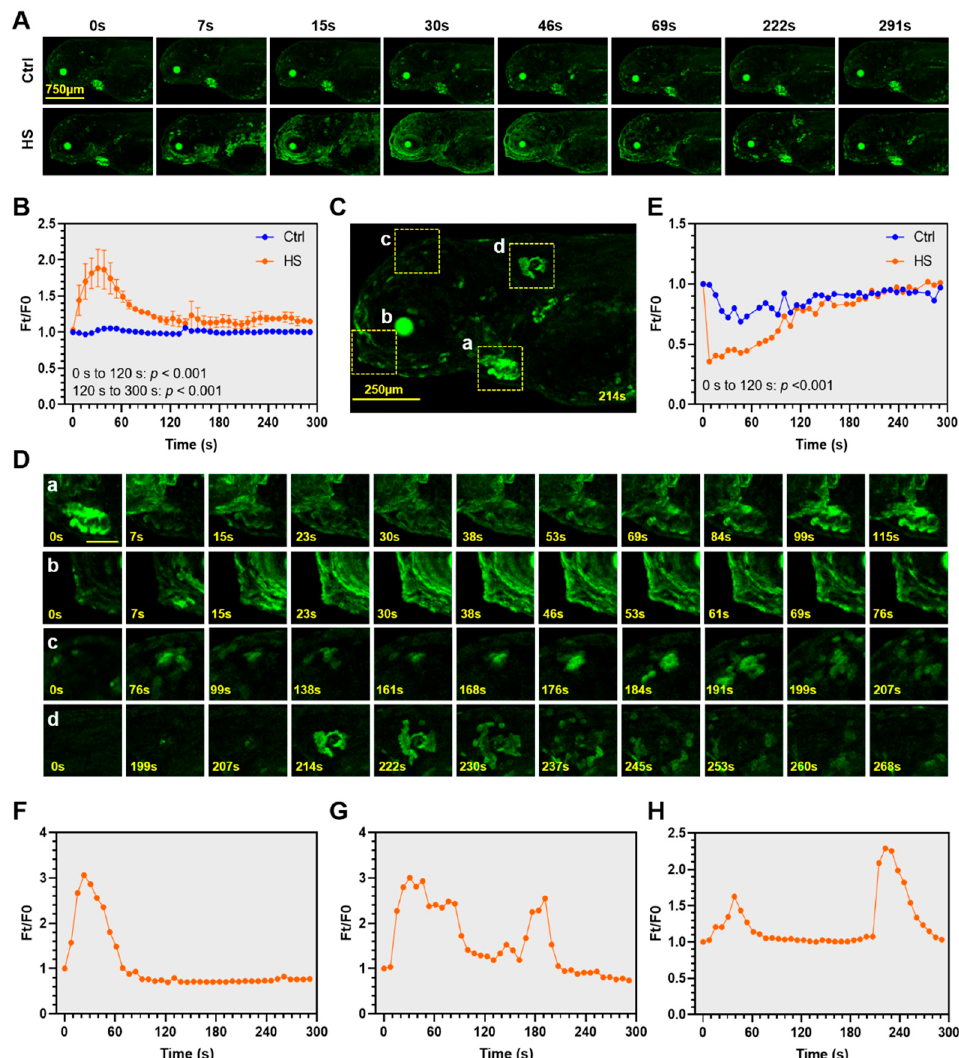
Figure 4. Spatiotemporal dynamics of the heat-elicited Ca 2+ signaling in zebrafish larvae. ( A ) Representative time-lapse confocal microscope images illustrating dynamics of the heat-elicited Ca 2+ signaling. E3 medium preconditioned at 28 ◦ C was added to the control (Ctrl), while heat shock (HS) was exerted by adding E3 medium at 40 ◦ C. The time points at which the images were taken are shown above the corresponding images. ( B ) Overall GCaMP6s fluorescence dynamics upon heat stress. The y-axis indicates the ratio of fluorescence intensity at different time points (Ft) to that before heat shock (F0). The x-axis indicates time duration under heat stress. Data are shown as mean ± standard error ( n = 3). ( C ) A magnified image indicates the organs and regions (enclosed by dashed rectangles) demonstrating marked changes in GCaMP6s fluorescence upon heat stress. ( a ), heart; ( b ), region around the mouth protruding; ( c ), region above the eye; ( d ), a neuromast-like structure. ( D ) Magnified images of the organs and regions marked in ( B ). The scale bar represents 200 µ m. ( E ) Exposure to heat stress transiently decreased intracellular Ca 2+ concentration in the heart of zebrafish larvae. ( F – H ) Line charts demonstrating fluorescence dynamics of the representative anatomical structures shown in ( Cb – d ). ( F ) Region around mouth protruding ( Cb ). ( G ) Region above the eye ( Cc ). ( H ) A neuromast-like structure ( Cd ). The measurements were repeated at least three times and representative results are